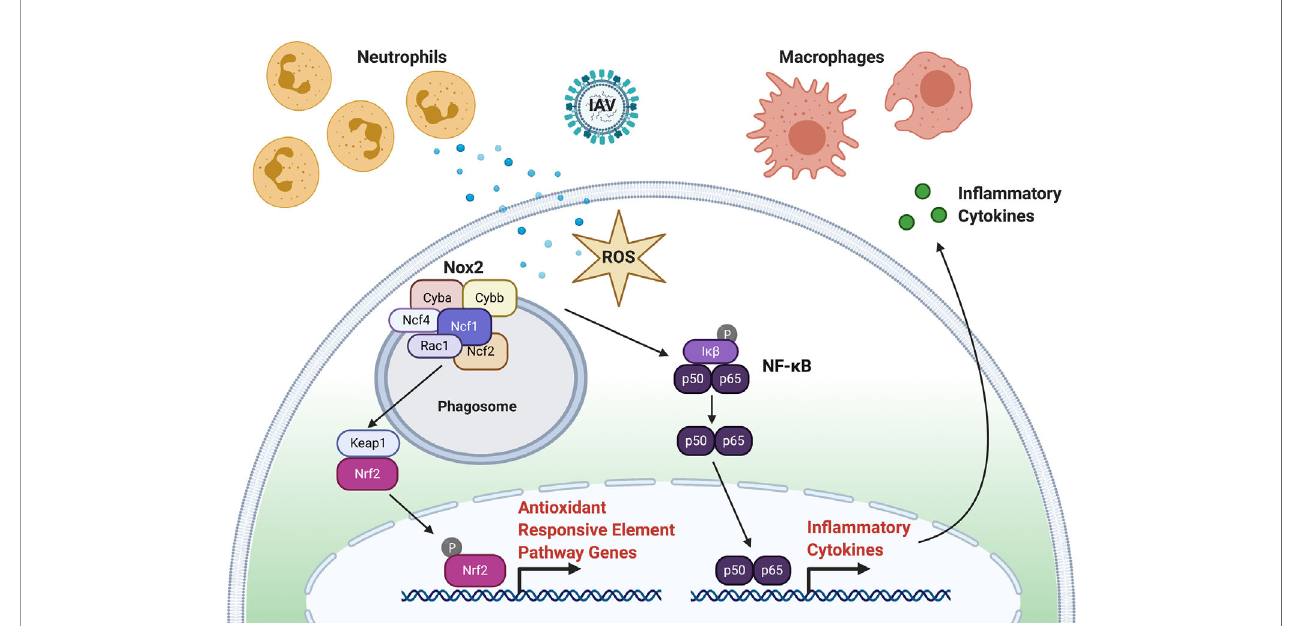
FIGURE 2 | ROS Signaling in Response to Virus Infection. Following infection, production of ROS through the respiratory burst response function to recruit phagocytes (neutrophils and macrophages) to the site of infection and inactivate virus particles. Activation of the phagocyte nicotinamide adenine dinucleotide phosphate (NADPH) oxidase (PHOX) complex produces ROS. The PHOX complex is composed to Cyba, Cybb, Ncf1, Ncf2, Ncf4, and Rac1. Activated Nox2 can activate NF k B (p60, p65) that leads to subsequent in fl ammatory chemokine and cytokine expression. Activated Nox2 can also activate the NRF2 transcription factor through KEAP1 to initiate the expression of